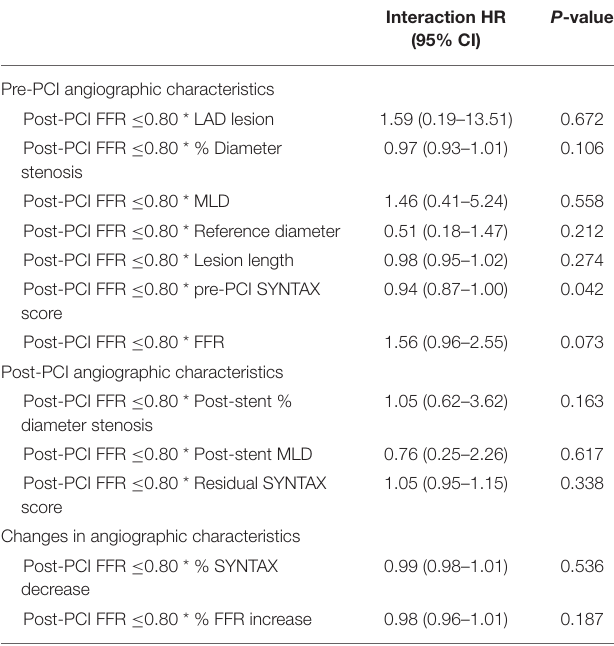
TABLE 2 | Coronary disease characteristics affecting the clinical relevance of residual